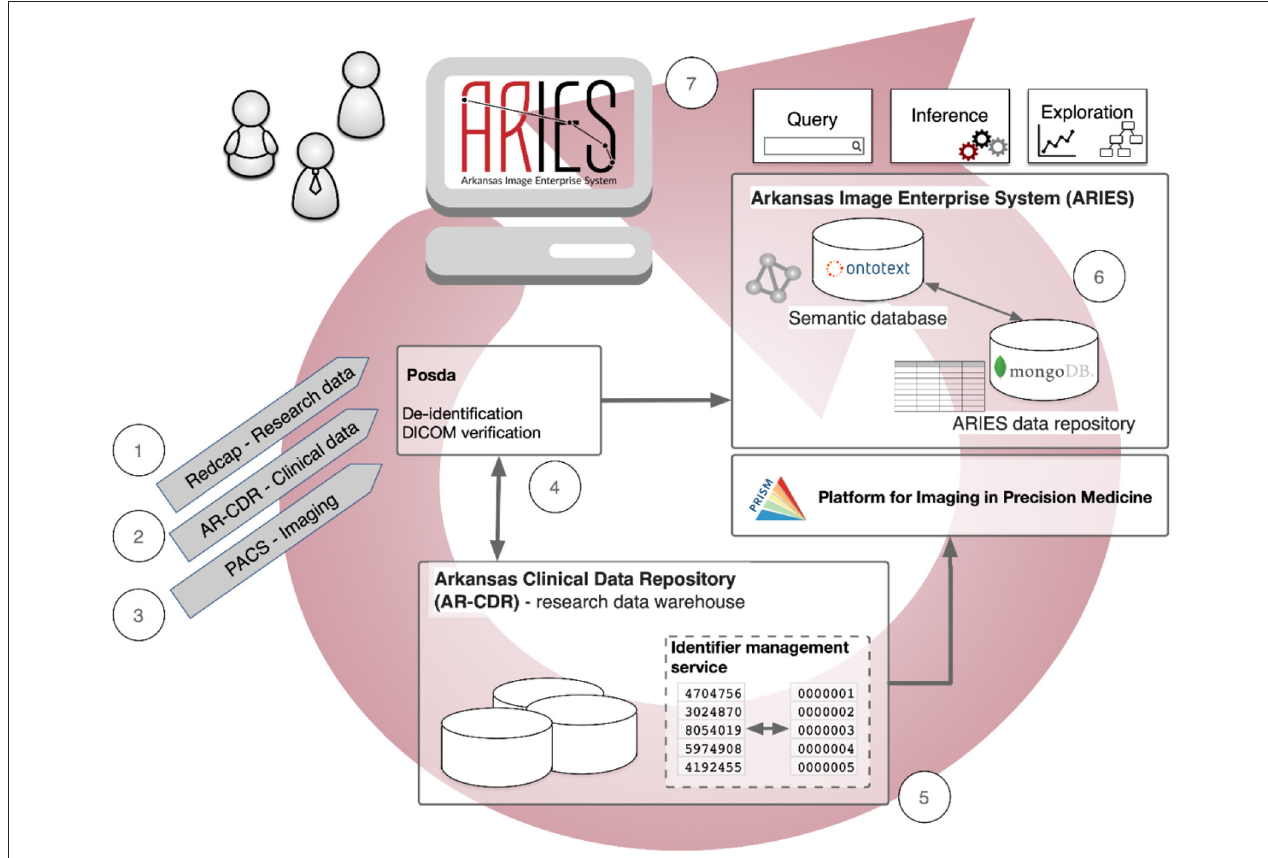
FIGURE 1 | Data management pathways and informatics processes in the Arkansas Imaging Enterprise System